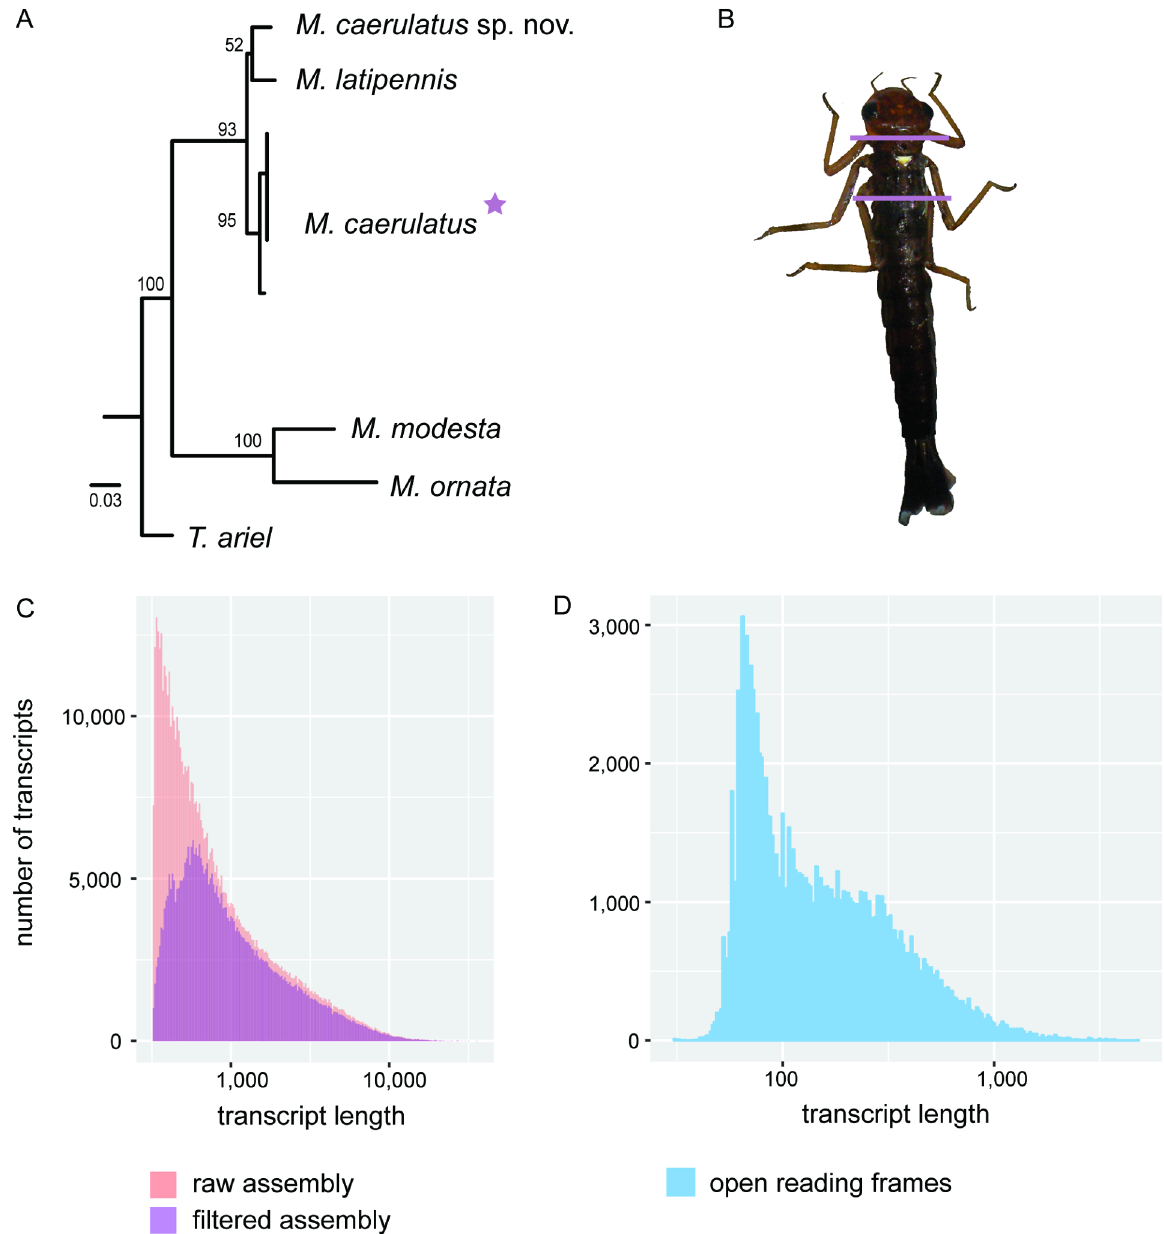
Fig 1. Thorax transcriptome of Megaloprepus caerulatus . A) Phylogeny basedon the 16S rRNA gene showingthe positionof Megaloprepuscaerulatus within the Pseudostigmatidaeusing Teinobasisariel as outgroup(cf. [19]). The NCBI accession numbers are: KF895223,DQ642987, KF895193, JQ966660,KF895130, KF895162,JQ966657, DQ642983, JQ966662.B) Exemplary illustrationof a M . caerulatus larva–hereof about 2.5–3 cm in length. The section betweenthe two lines indicatesthe tissue used for RNA extraction. C) Difference in the number of transcripts over transcript length betweenthe raw assemblyand the filtered assembly. The filtering reducedredundancyand the amount of shorter transcripts. D) Lengthdistributionof the final predictedopen reading frames. Note whereasin plot B both axes are logarithmic; in C, only the x-axis is